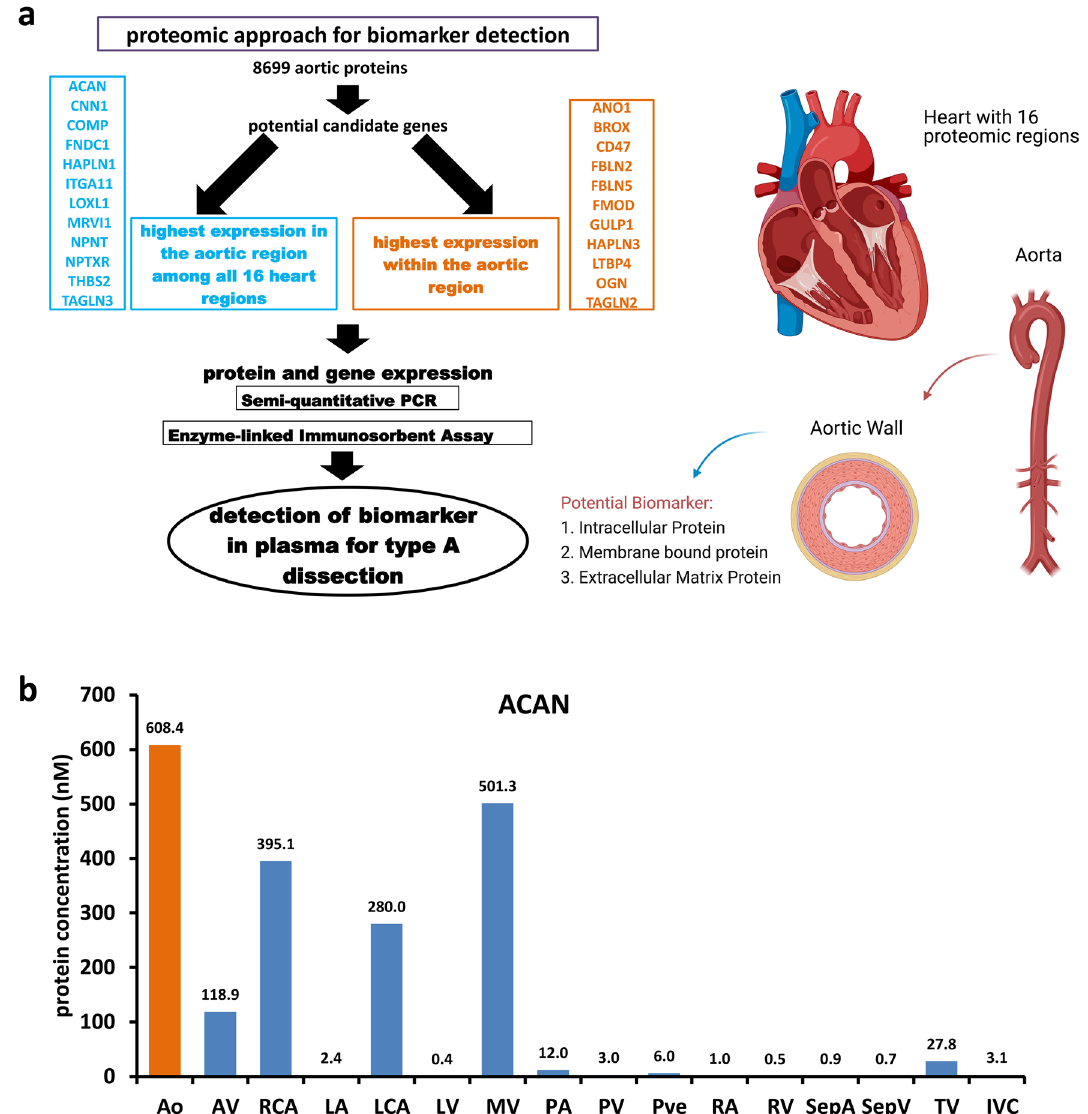
Figure 1. Workflow to identify candidate markers for acute type A aortic dissection patients and expression of selected candidate genes in human heart regions and surgical biopsies. (a) Strategy for selection and measurement of candidate biomarkers. (b) Protein expression of ACAN in different regions of the human heart. Ao aorta, AV aortic valve, RCA right coronary artery, LA left atrium, LCA left coronary artery, LV left ventricle, MV mitral valve, PA pulmonary artery, PV pulmonary valve, Pve pulmonary vein, RA right atrium, RV right ventricle, SepA atrial septum, SepV ventricular septum, TV tricuspid valve, IVC inferior vena cava